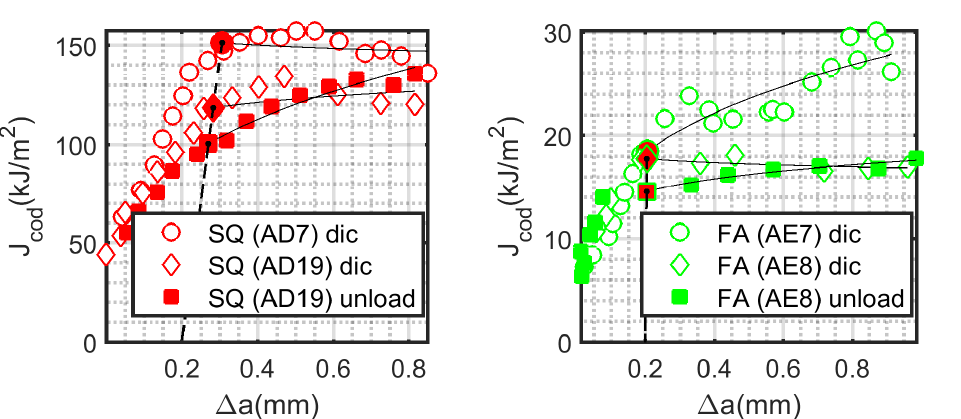
Figure 2. R-curves of sintered and quenched (SQ) and forged and annealed specimens (FA). The construction lines intersecting the mesured curve at J Ic are marked. The crack length is measured by DIC or from unloading compliance.